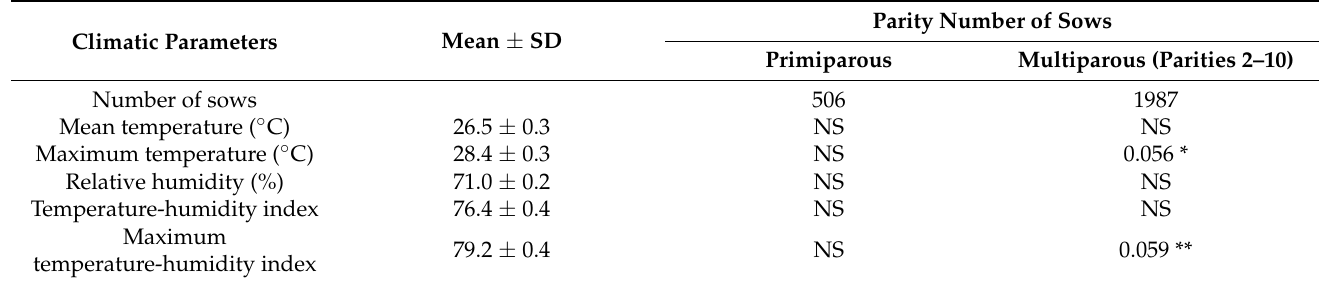
Table 6. Pearson’s correlations between farrowing duration and climatic parameters during the 7-day period before farrowing in sows by parity